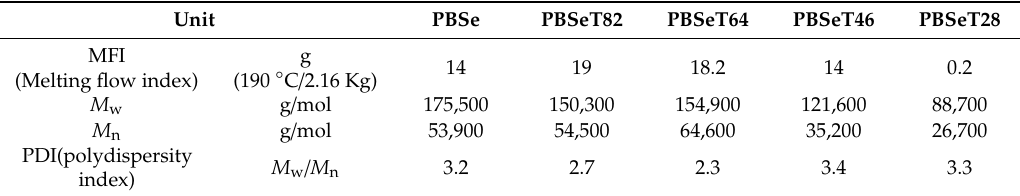
Figure 3. Gel permeation chromatography (GPC) plots of the synthesized PBSeT polyesters. Table 3. Melting flow index, polymer molecular weight and polydispersity index ( M w / M n ) of